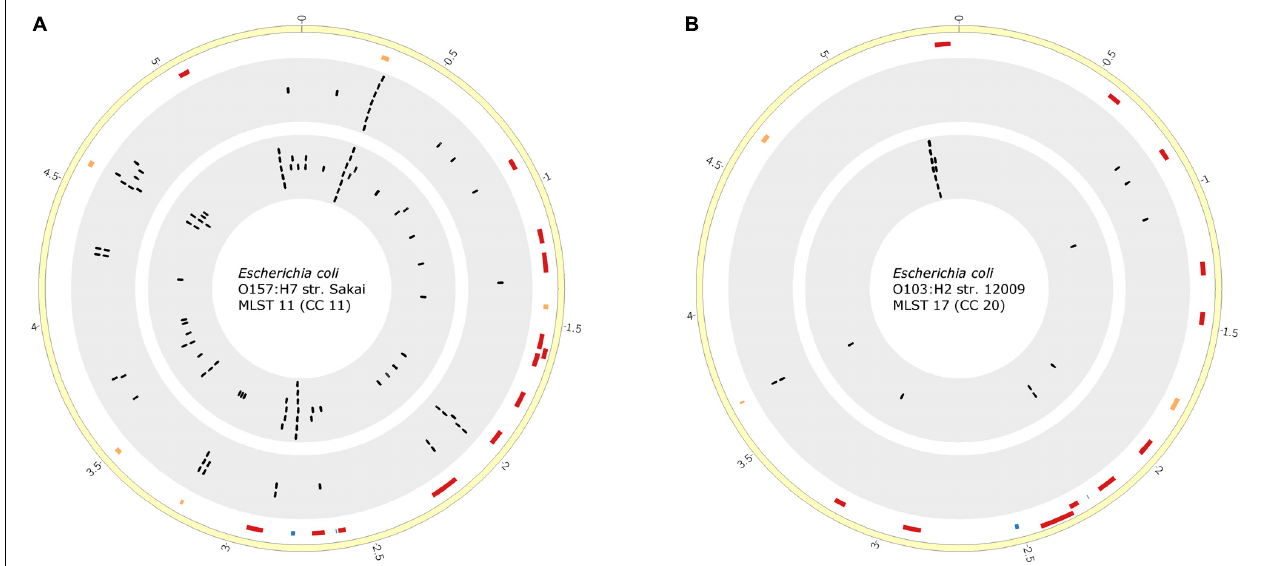
FIGURE 5 | Comparison of marker gene prediction pipeline A based on an enlarged set of genomes with pipeline B. Visualization of specific marker genes identified for STEC isolates of CC11 (A) and CC20 (B) . The yellow ring represents the chromosome of STEC reference O157:H7 strain Sakai (CC11) (A) or O103:H2 strain 12009 (CC20) (B) . The second ring depicts bacteriophage-related regions (orange, fragmented; red, intact) within the genomes of the reference strains identified with PHAST (Zhou et al., 2011). Blue markers indicate the localization of O- and H-antigen-related genomic regions. The third ring (gray background) depicts the genomic localization of CC-specific biomarker candidates identified by bioinformatics pipeline A. The fourth ring (gray background) represents the genomic localization of CC-specific biomarker candidates predicted by bioinformatics pipeline B. The plots were generated with CIRCOS (v 0.69) (Krzywinski et al., 2009). TABLE 3 | Amount of biomarkers after checkpoints given in Figure 1 for each genome subgroup used for bioinformatics pipeline A. STEC subgroup Number of Number of biomarkers Number of biomarkers Number of biomarkers Number of biomarkers genomes after pipeline after BLASTp verification used for in vitro after in vitro validation (Checkpoint 1) (Checkpoint 2) validation (Checkpoint 3) (Checkpoint